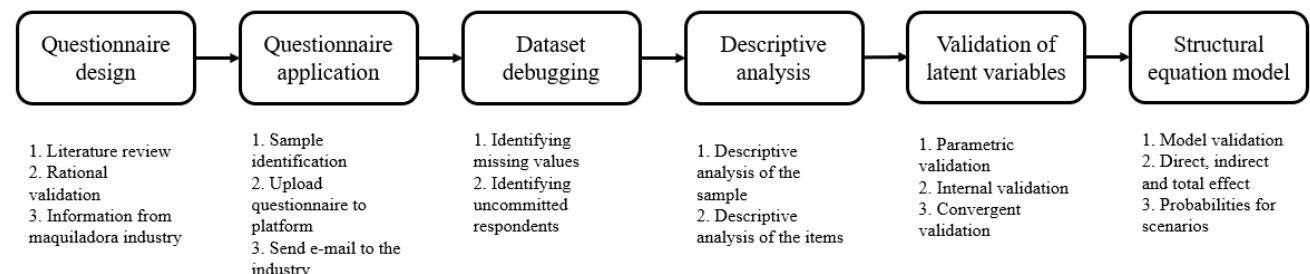
Figure 1. Proposed model of the relationships between LM tools and sustainability.